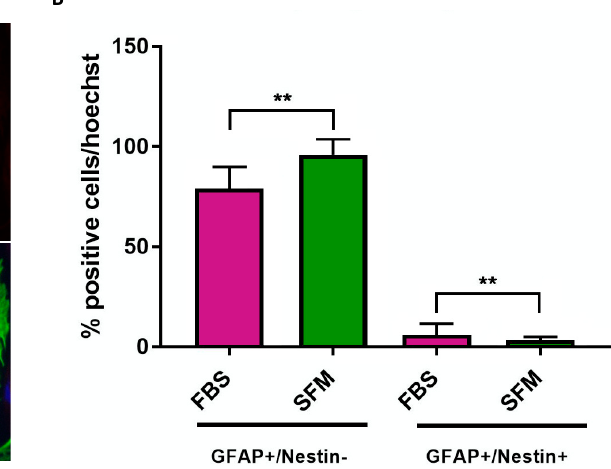
Figure 3. Long ‐ term maintained in culture CX Astrocytes exhibited time ‐ dependent maturation. ( A ) Representative immunofluorescence pictures of CX APC cultures at DIV 40 of exposure to AMM ‐ SFM. Cultures were stained for Nestin and GFAP expression. Nuclei were stained with Hoechst. Scale bar: 75 μ m. ( B ) Graph showing the percentage of GFAP + /Nestin − (astrocytes) and GFAP + /Nestin + (APCs) cells in DIV 40 cultures exposed to AMM ‐ FBS (purple bars) or AMM ‐ SFM (green bars). The percentage was normalized over the total number of cells assessed by Hoechst staining. Data were expressed as the means ± STDV ( n = 3 biologically independent experiments). p < 0.01 (**), and not significant (ns) according to Student’s t ‐ test analysis. ( C ) Representative immunofluorescence pictures of CX APC cultures at DIV 40 of exposure to AMM ‐ SFM in which it is possible to observe the two typical morphologically distinct flat fibrous ‐ like morphology and flat fibrous ‐ like astrocyte populations. Cultures were stained for Nestin and GFAP expression. Nuclei were stained with Hoechst. Asterisks indicated astrocytes with flat fibrous ‐ like morphology; arrows indicated astrocytes with protoplastic/reactive morphology. Scale bar: 75 μ m. ( D ) Graphs reporting the number of GFAP + /Nestin − (astrocytes) cells with flat fibrous ‐ like morphology (purple) or with protoplastic/reactive morphology (green) in CX APC cultures exposed for 3, 10, 25 and 40 DIV to AMM ‐ SFM. The percentage was normalized over the total number of GFAP + /Nestin − (astrocytes) cells. Data were expressed as the means ± STDV ( n = 3 biologically independent experiments). P < 0.05 (*), p < 0.001 (***) and not significant (ns) according to Student’s t ‐ test analysis.